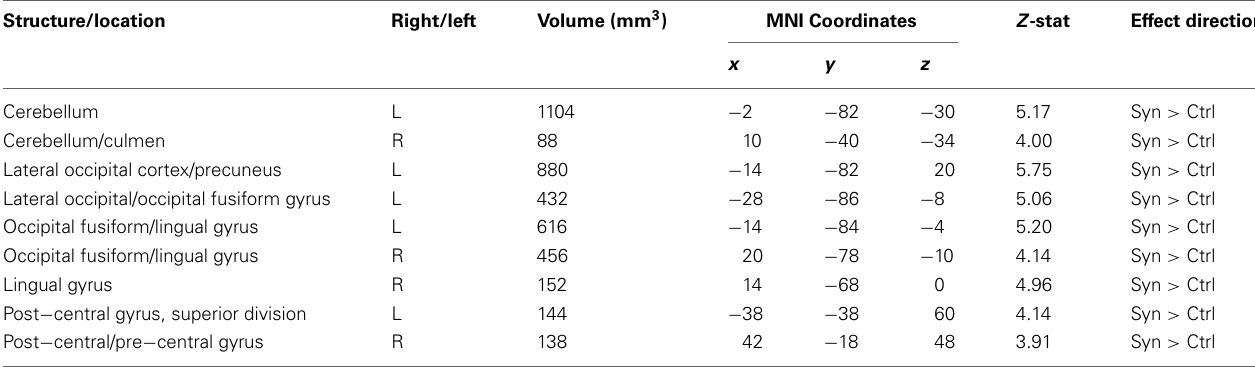
P = 0.01 FDR corrected for multiple comparisons with minimum cluster size = 10mm 3 . The XYZ coordinates relate to the approximate Center Of Mass (COM) in each case.